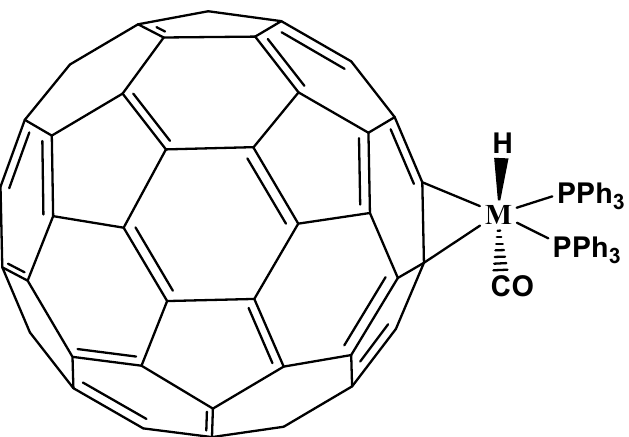
Figure 4. Typical η 2 fullerene organometallic complex